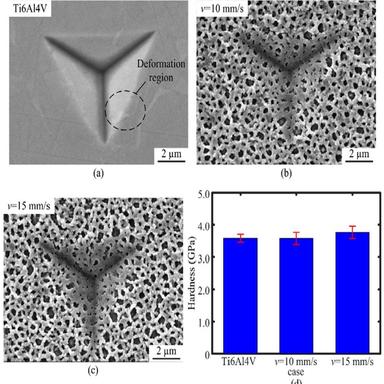
SEM morphologies of the residual indents on (a) the Ti6Al4V surface, as well as the surfaces with nanoporous structures obtained under different laser scanning speeds (P = 1.48 W, r = 76.6 %, f = 700 kHz): (b) v = 10 mm/s and (c) v = 15 mm/s. (d) The distribution of surface hardness corresponding to the residual indents shown in Fig. 9(a), (b), and (c). The indentation load is kept to 100 mN.